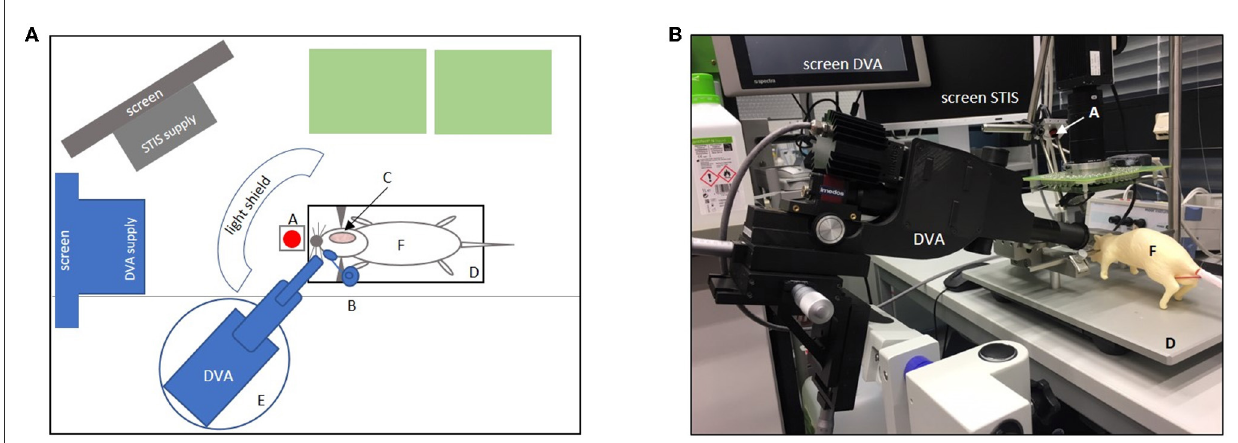
FIGURE2 Experimental set-up. (A) Shows the set-up in the aerial view. Green boxes = life support supplies (e.g., respirator, Perfusor, and blood pressure monitor); gray boxes = computer screen with laser speckle system (STIS) supply; gray half-moon = light shield; blue boxes = dynamic vessel analyzer (DVA) and DVA supply including a screen for video analysis (A, laser diode for laser speckle contrast; B, micromanipulator with a contact lens placed in front of the right eye; C, cranial bone window; D, stereotactic frame with heating plate and animal in supine position; E, lifting jack for the adjustment of the DVA; F, dummy. (B) Original set-up with dummy showing the DVA with DVA supply screen and a second screen for laser speckle imaging (STIS). A, laser speckle system (STIS); D, stereotactic frame; F = dummy. Micromanipulator with contact lens and light shield not shown here.